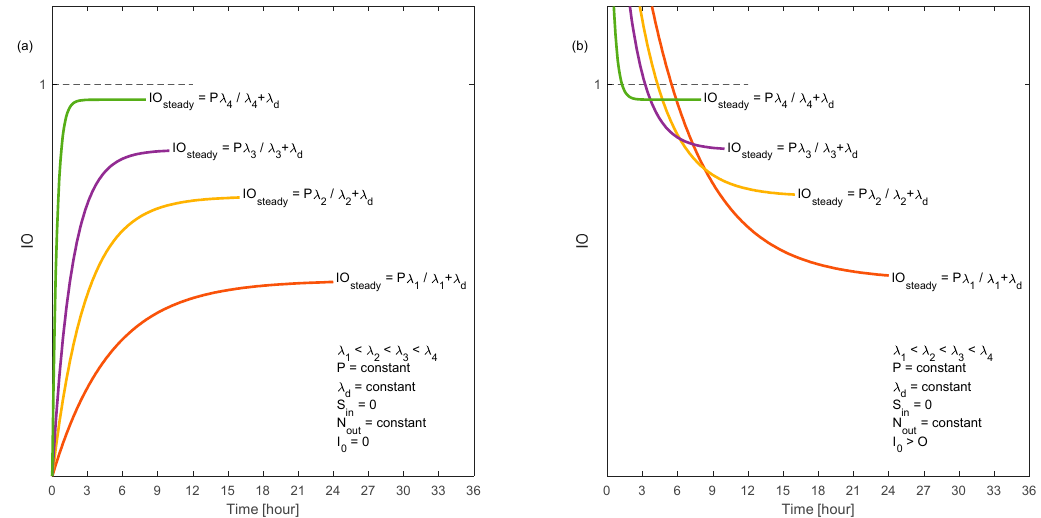
Figure A2. Role of the ventilation rate ( λ ) on the steady state indoor aerosol concentration (i.e., steady state indoor-to- outdoor concentration IO steady ) ( a ) when the initial indoor aerosol concentration I 0 = 0 and ( b ) when the initial indoor aerosol concentration is higher than that outdoors (i.e., I 0 > O). All other indoor aerosol parameters are held constant, as shown on the subplots.